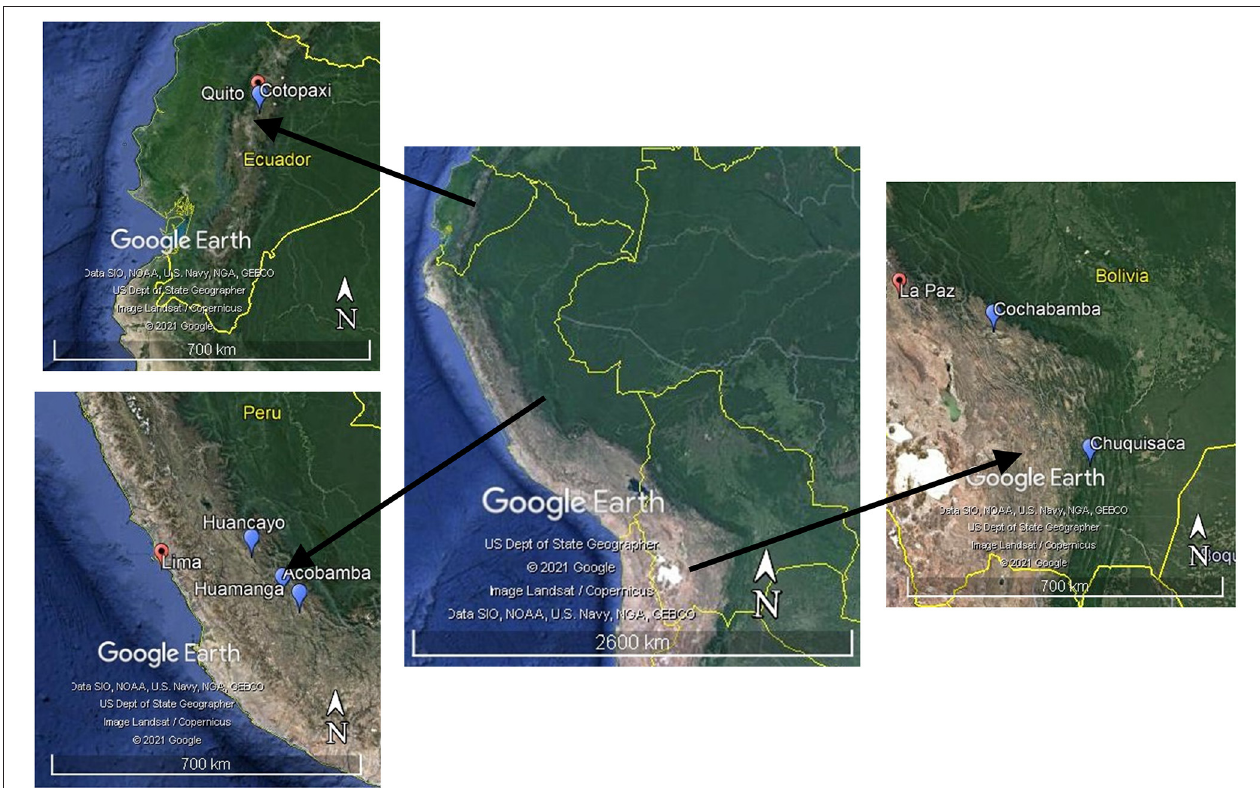
FIGURE 2 | Geographical location of the study sites. Red pins indicate capital cities, blue pins indicate study